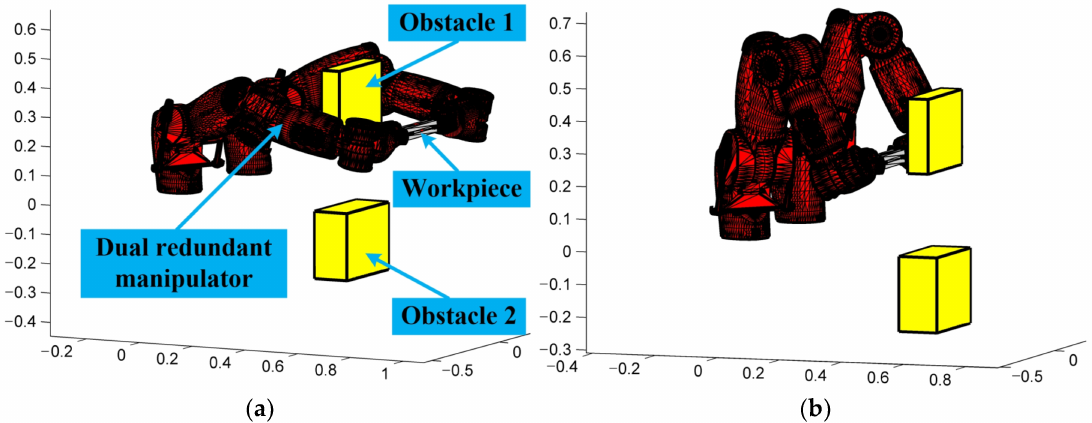
Figure 3. Simulation platform: ( a ) initial state; ( b ) goal